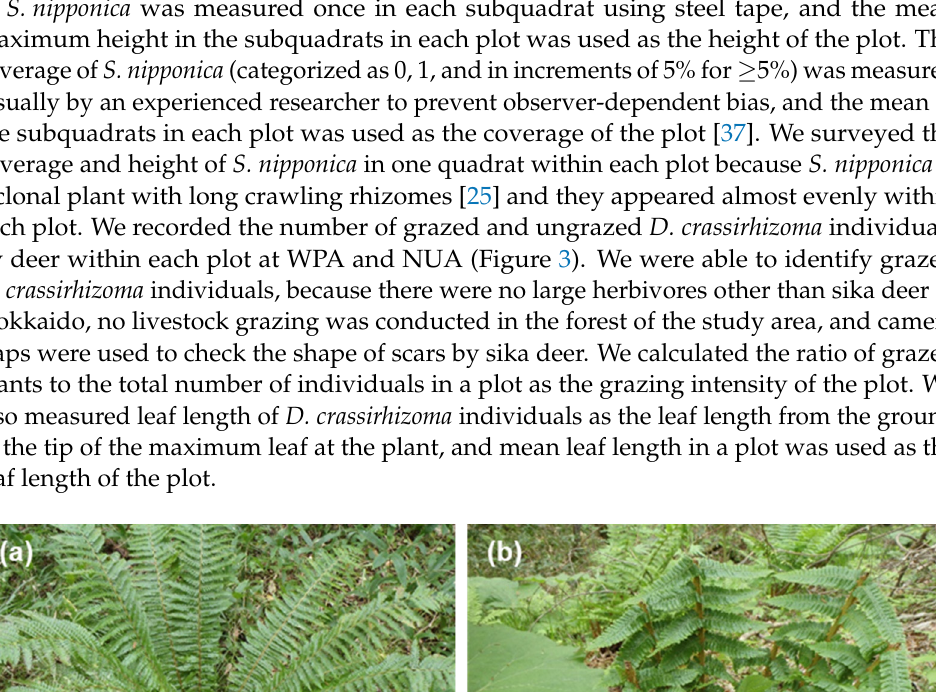
Figure 3. Photographs of Dryopteris crassirhizoma individual of ( a ) ungrazed and ( b ) grazed all-leaves by sika deer.